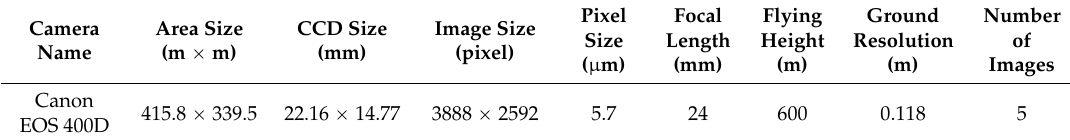
Table 1. The parameters of the photography from Northwest University (unmanned aerial vehicle images). Camera